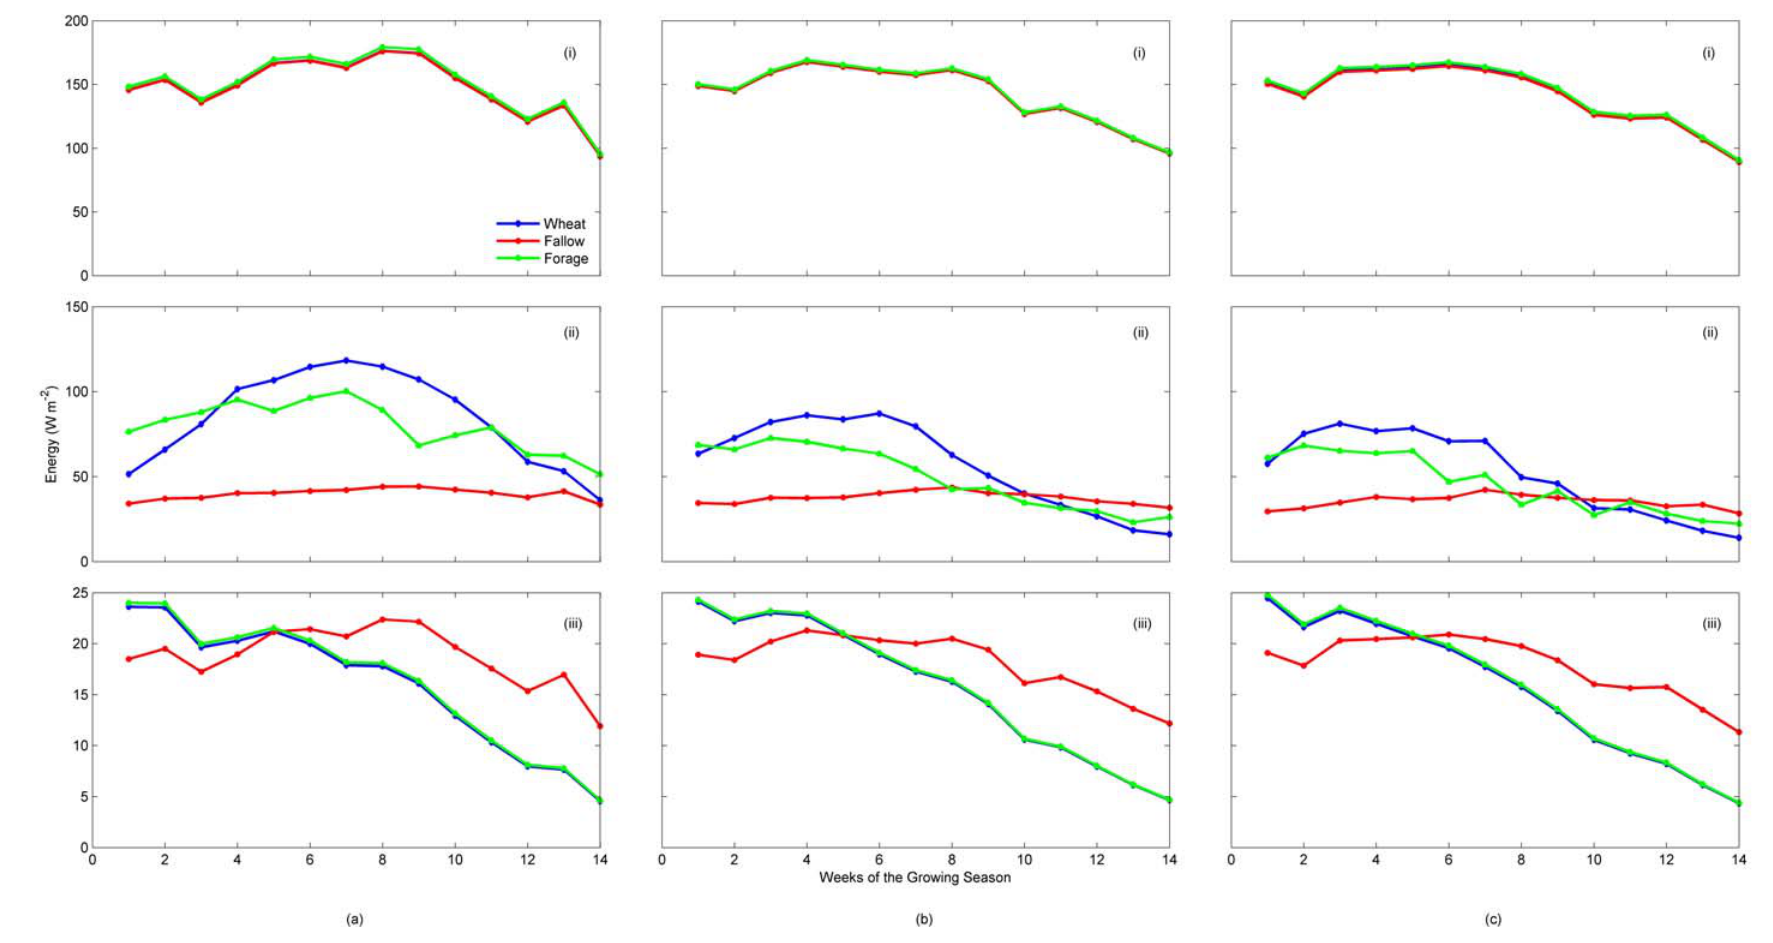
Figure 4. Mean (1997–2004) daily energy fluxes over specified vegetation covers: (i) net radiation, (ii) latent heat, and (iii) soil heat at representative weather stations ( a ) Brandon-Black soil zone, ( b ) Lethbridge-Dark Brown soil zone, and ( c ) Vauxhall-Brown soil zone during the growing season. Week #1 is the last week of